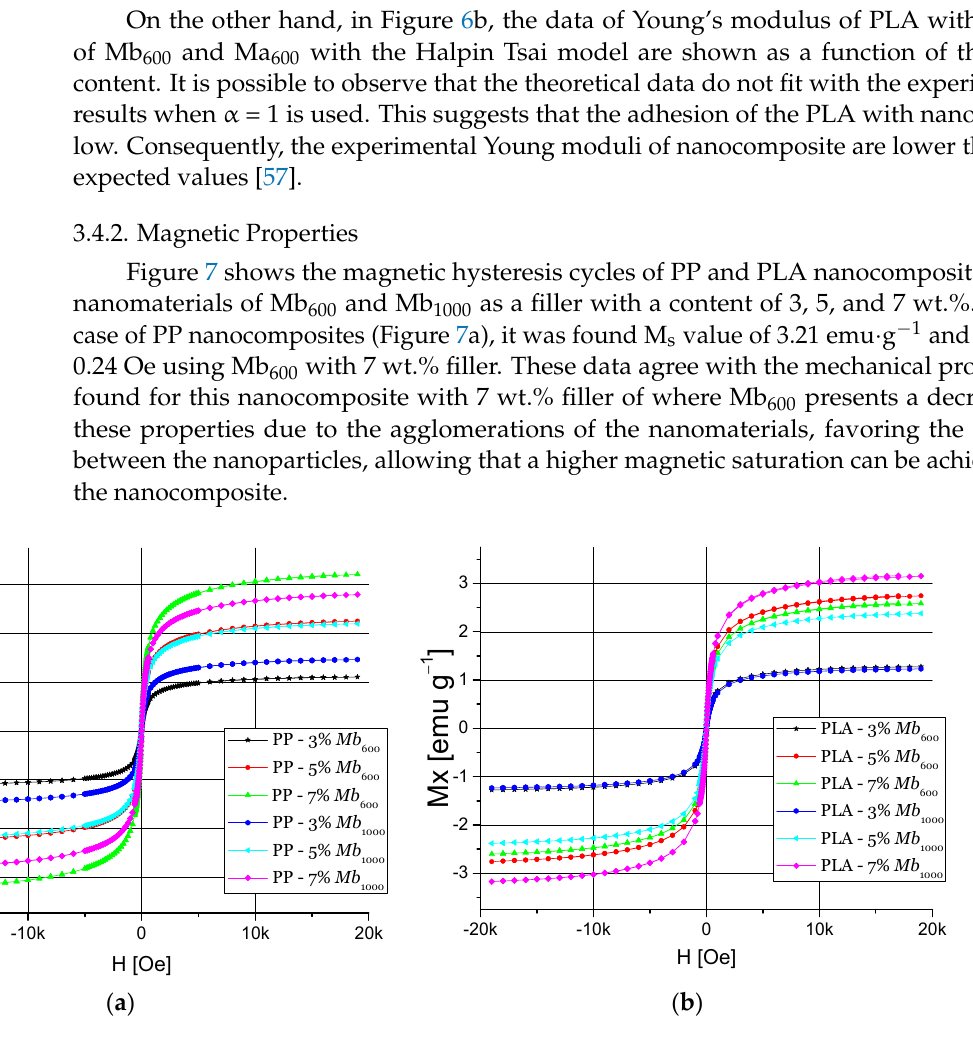
( b ) Figure 8. Magnetic hysteresis cycles: ( a ) PP:Ma 600 and Ma 1000 and ( b ) PLA:Ma 600 and Ma 1000 nanocomposites.